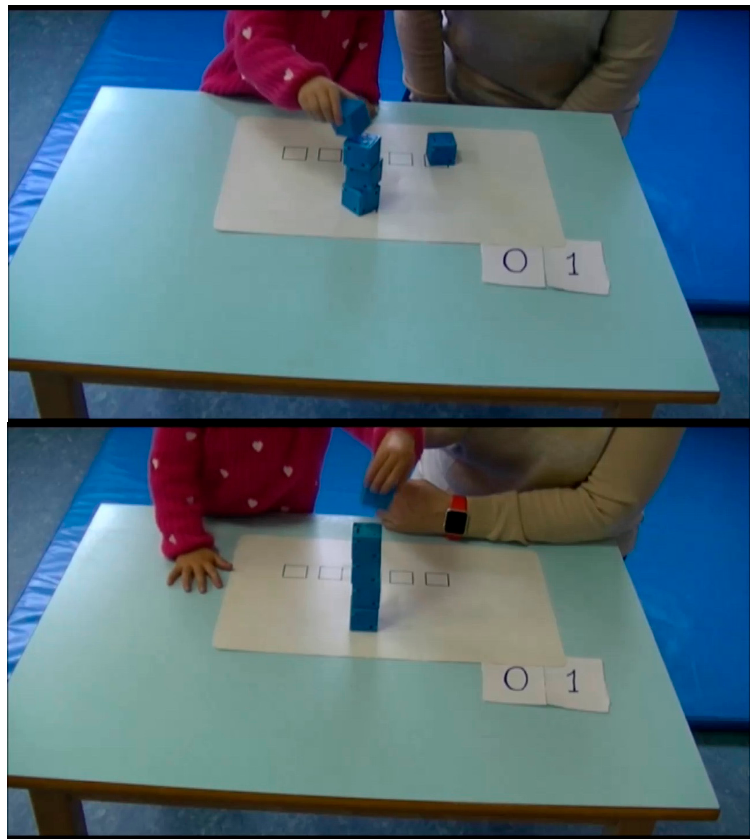
Figure 1. A child building a five-cube tower.